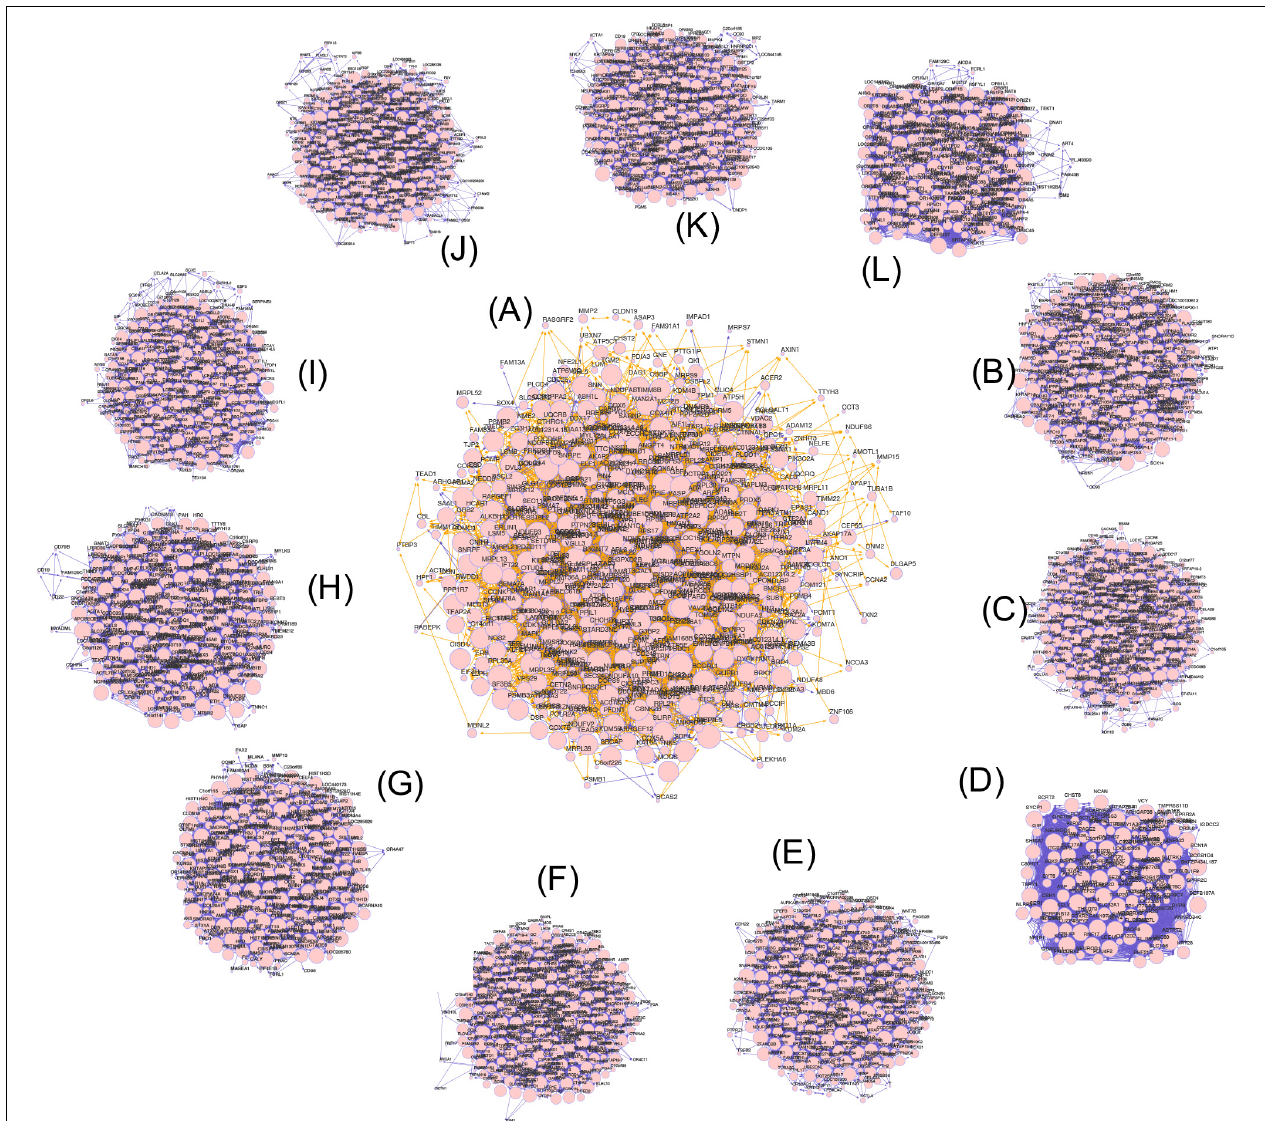
FIGURE 1 | Gene co-expression networks of villi and multiple tumors. (A) The gene co-expression networks of villi. (B–L) The gene co-expression networks of BLCA, BRCA, COAD, READ, EAC, GBMLGG, HNSC, LUAD, STAD, ESCC, and LUSC, respectively. The edge weight indicates the statistical significance of the gene co-expression relationship, the edge color indicates the direction of the association (positive shown in yellow; negative shown in blue), and the node size indicates the node degree.